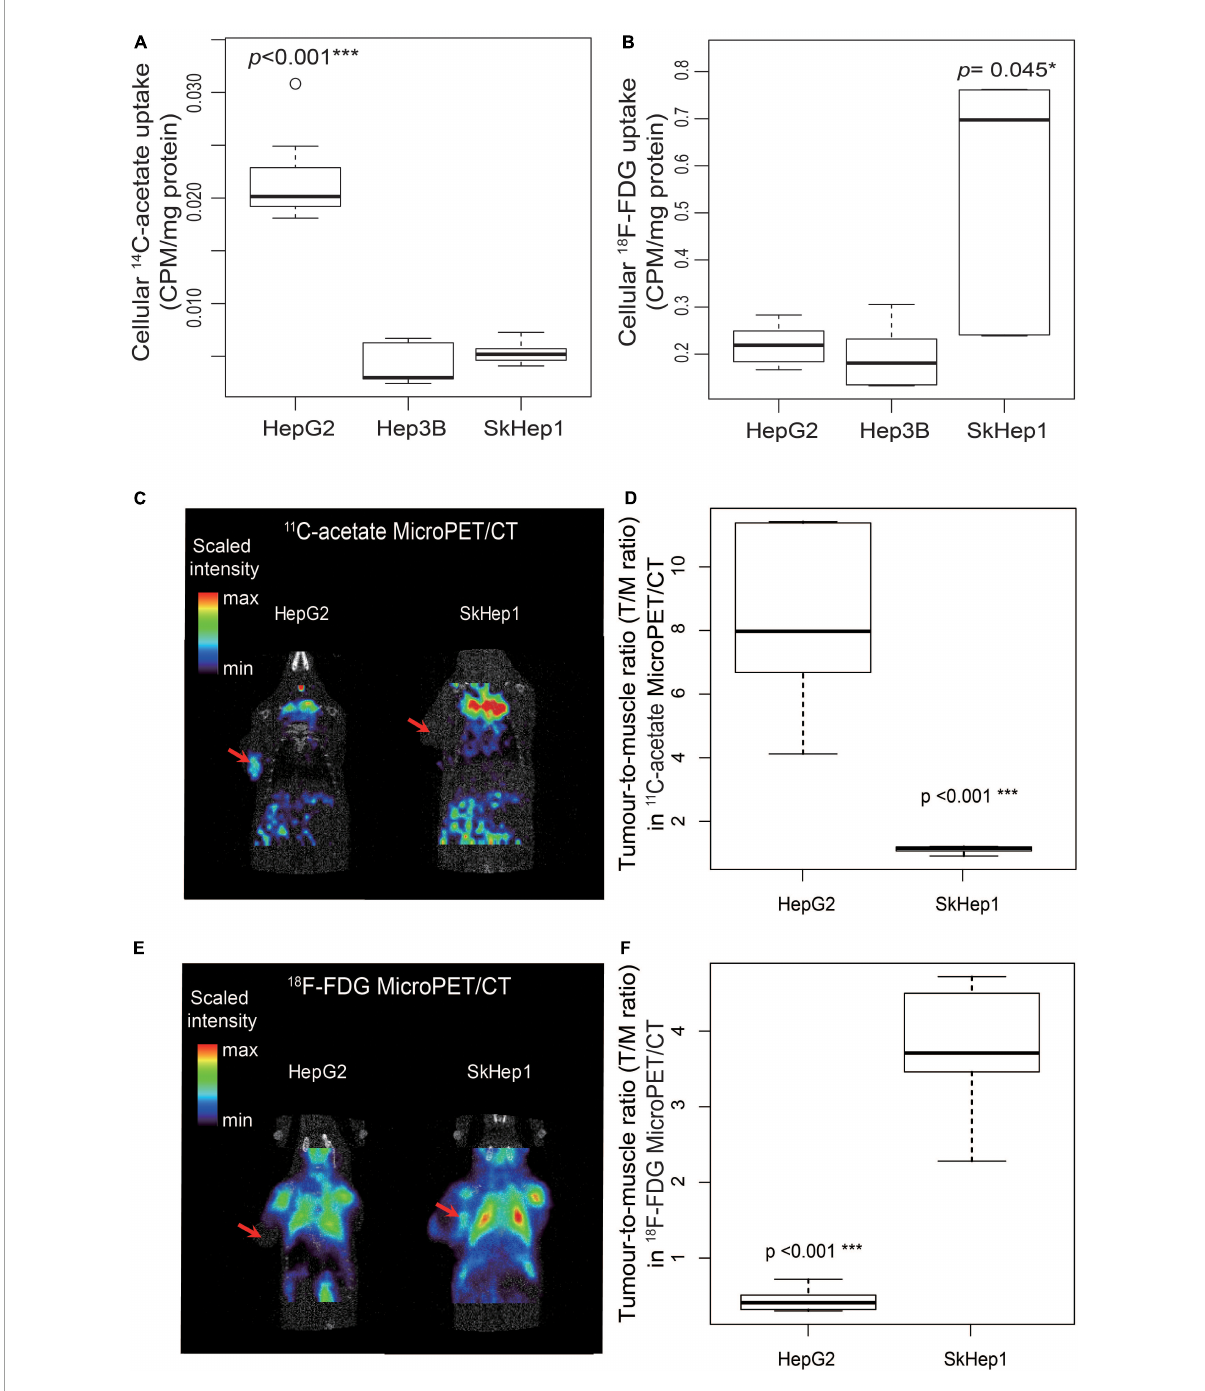
FIGURE2 Dual-tracer uptake in three HCC cell lines in vitro and in vivo . In vitro , (A) 14 C-acetate uptake in HepG2 cells is significantly higher than that in SkHep1 and Hep3B cells (Kruskal–Wallis test *** p < 0.001; n = 7, 10, and 10 for HepG2, Hep3B, and SKHep1, respectively). (B) 18 F-FDG uptake in SkHep1 cells is significantly higher than that in HepG2 and Hep3B cells (Kruskal–Wallis test * p = 0.045; n = 6, 6, and 5 for HepG2, Hep3B, and SKHep1, respectively). In vivo , (C) 11 C-acetate micro-PET imaging of HCC xenografts in nude mice, represented by a color-based radiometric scale, revealed that (D) 11 C-acetate uptake assessed using the tumor-to-muscle ratio is significantly higher in HepG2 cells than in SkHep1 cells ( D ; permutation test *** p < 0.001; n = 6 and 5 for HepG2 and SkHep1, respectively); whereas (E) 18 F-FDG micro-PET imaging of HCC xenografts revealed that (F) 18 F-FDG uptake is significantly higher in SkHep1 cells than in HepG2 cells ( F ; permutation test *** p < 0.001; n = 5 for each cell line). The red arrows in dual-tracer micro-PET imaging in C,E indicate the location of the HCC xenografts. We summarized the measurements as box-plots that label 25, 50, and 75% quantiles in the boxes with whiskers presenting at most 1.5 × interquartile